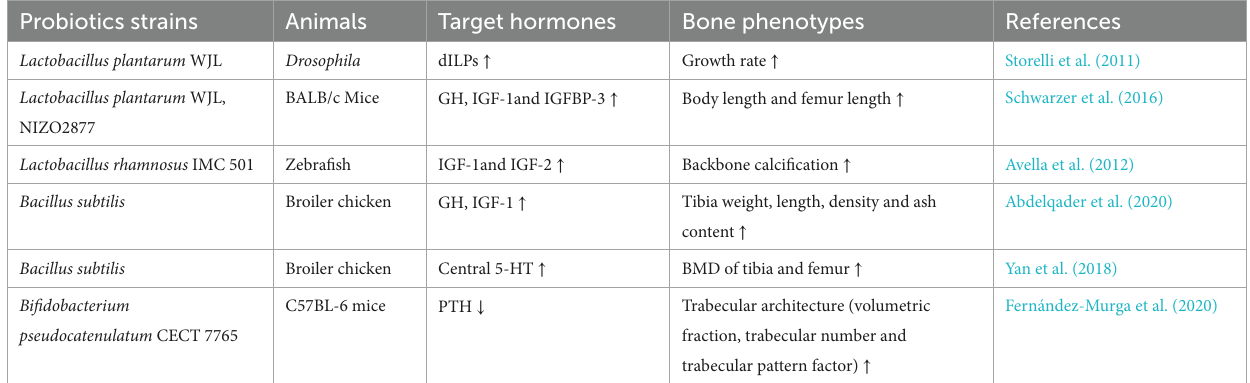
TABLE 1 The regulatory effect of probiotics on enteroendocrine-osseous axis. Probiotics